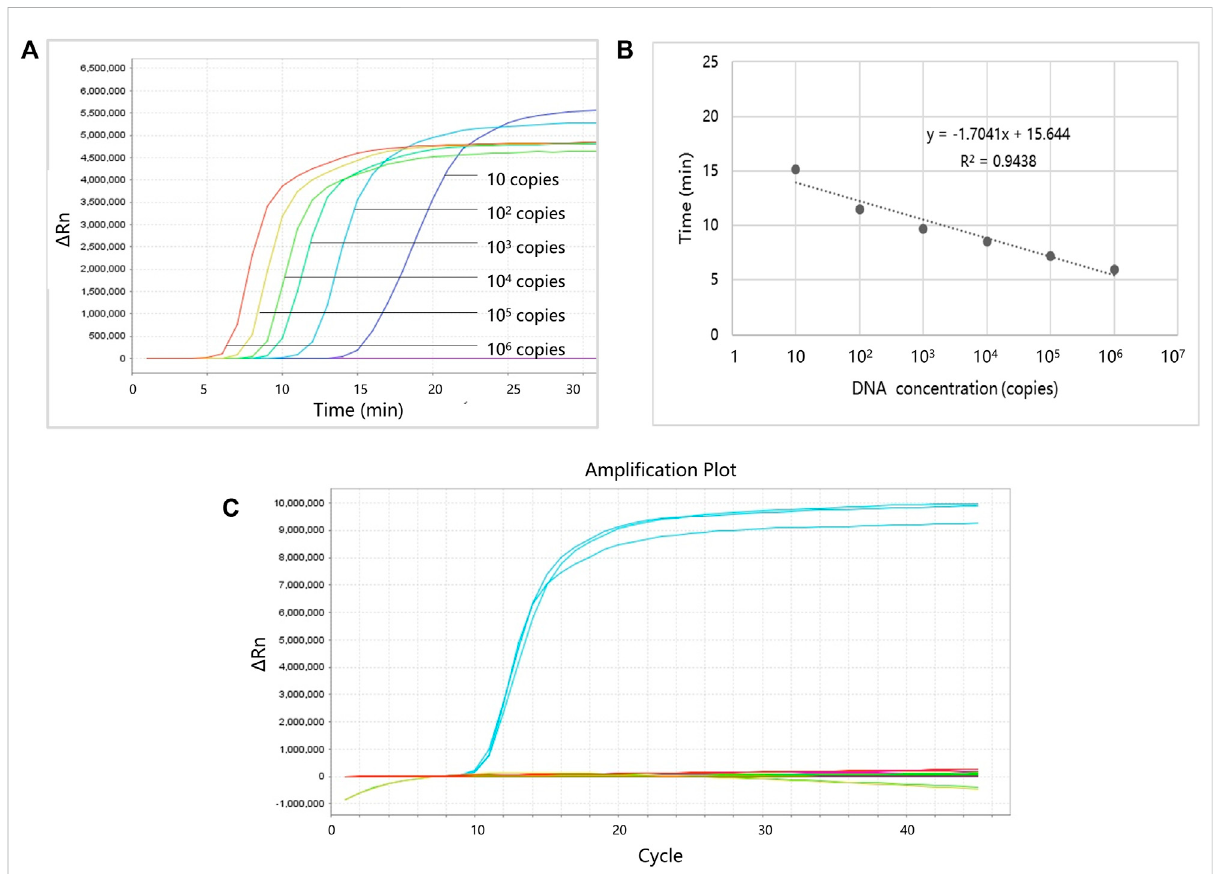
FIGURE 4 Limit ofdetection (LOD), linearity,and speci fi city analysis ofProGRP. (A) LODanalysis ofProGRP. (B) LinearityanalysisofProGRP. (C) Speci fi city analysis of